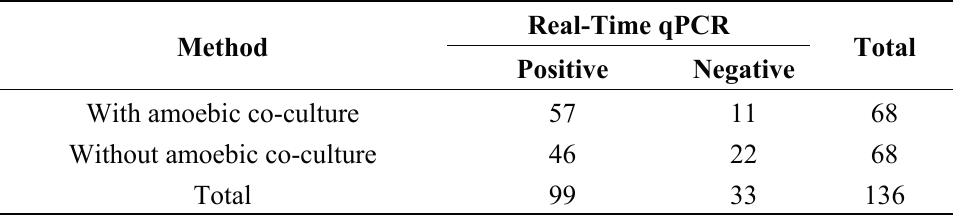
Table 5. Relation between amoebic co-culture technique and real-time qPCR method for detection of Legionella in bath water